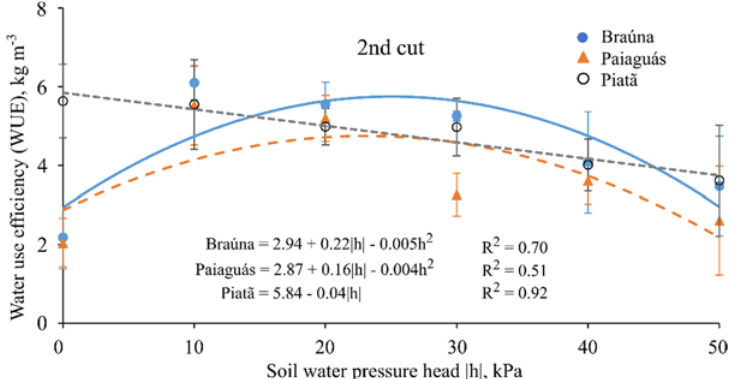
Figure 9. Regression models relating soil water pressure head to water use efficiency of Brachiaria brizantha cultivars for the second cutting period (70 DAE). Error bars correspond to the standard deviation of the four replicas.